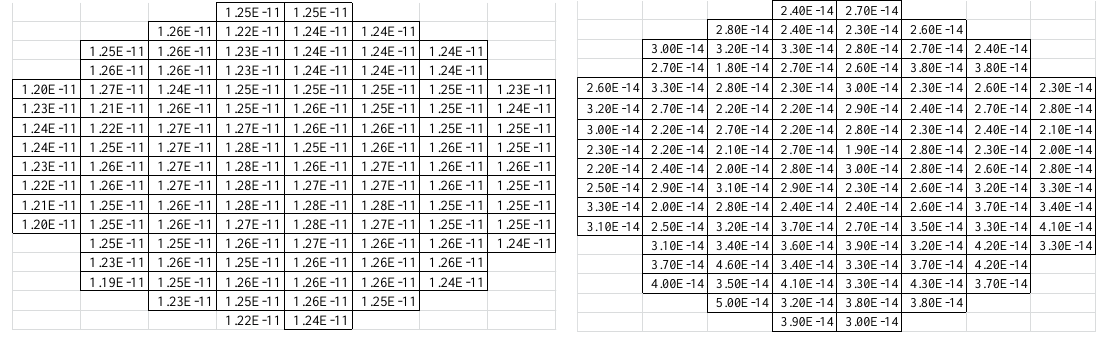
Figure 6. Full wafer CV ( Left ) and IV ( Right ) mapping test data of the sensor structure.